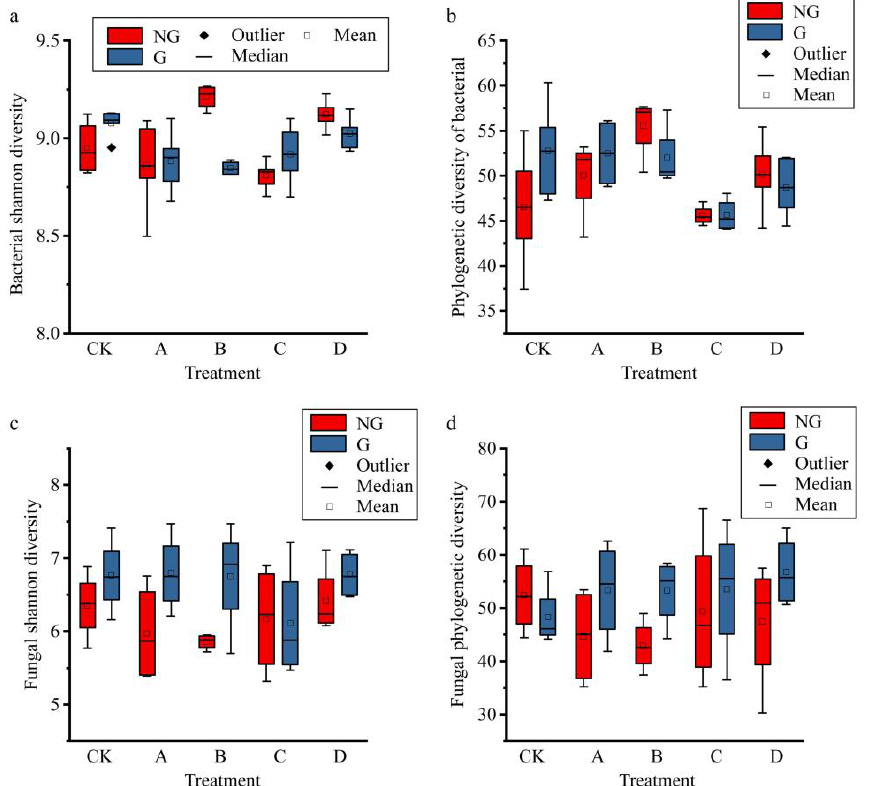
Figure 3. Effects of gradient warming and grazing on biodiversity of microbial community. ( a ), shannon diversity index of bacterial community; ( b ), phylogenetic diversity index of bacterial community; ( c ), shannon diversity index of fungal community; ( d ), phylogenetic diversity index of fungal community. The horizontal axis indicates the experimental treatments that resulted in different warming gradients. NG and G indicate treatments without simulated grazing and treatments with grazing,